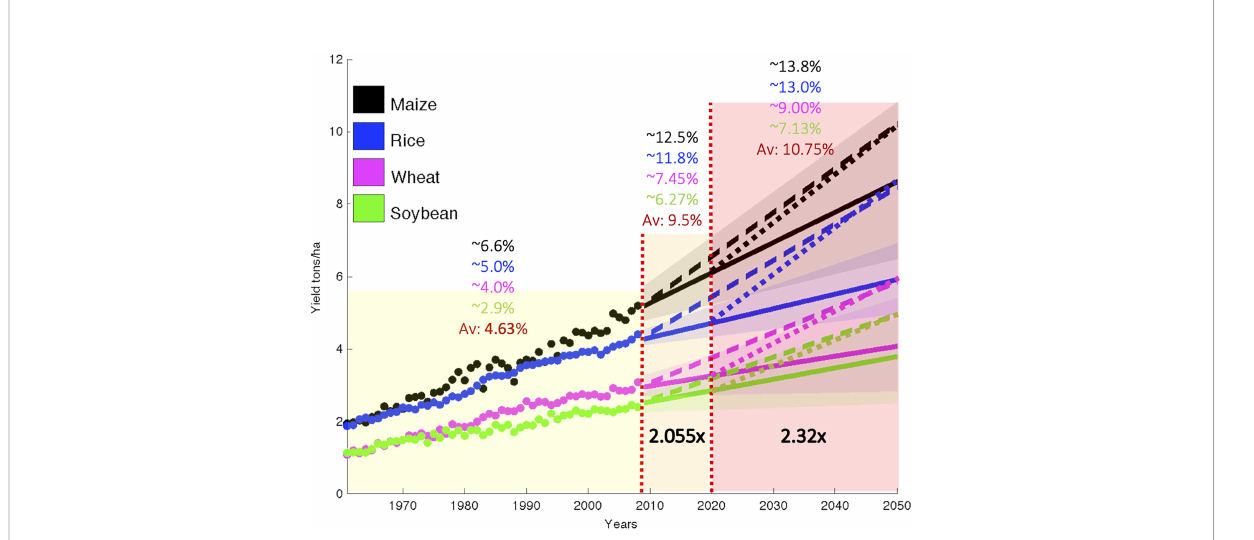
FIGURE 1 Observed area-weighted global yield 1961 – 2008 shown using closed circles and projections to 2050 using solid lines for maize, rice, wheat, and soybean. Shading shows the 90% con fi dence region derived from 99 bootstrapped samples. The dashed line shows the yield trend from 2008 needs to double production, on average, for these crops by 2050, without bringing additional land under cultivation starting in the base year of 2008. The dotted lines from 2020 to 2050 show the yield trend needs to increase by more than 2.3 times with respect to 2008. Adapted from (Ray et al.,